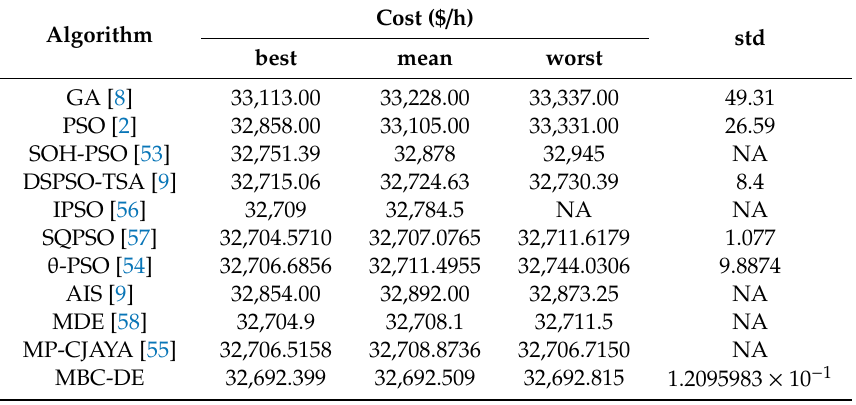
Table 10. Algorithms comparison between MBC_DE and other algorithms for test case 2.